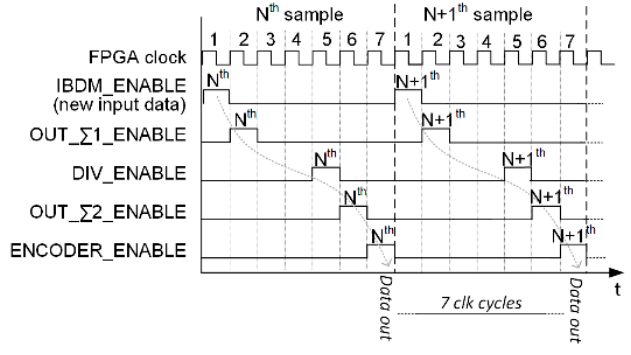
Figure 11. APD controller unit enable signals time diagram.